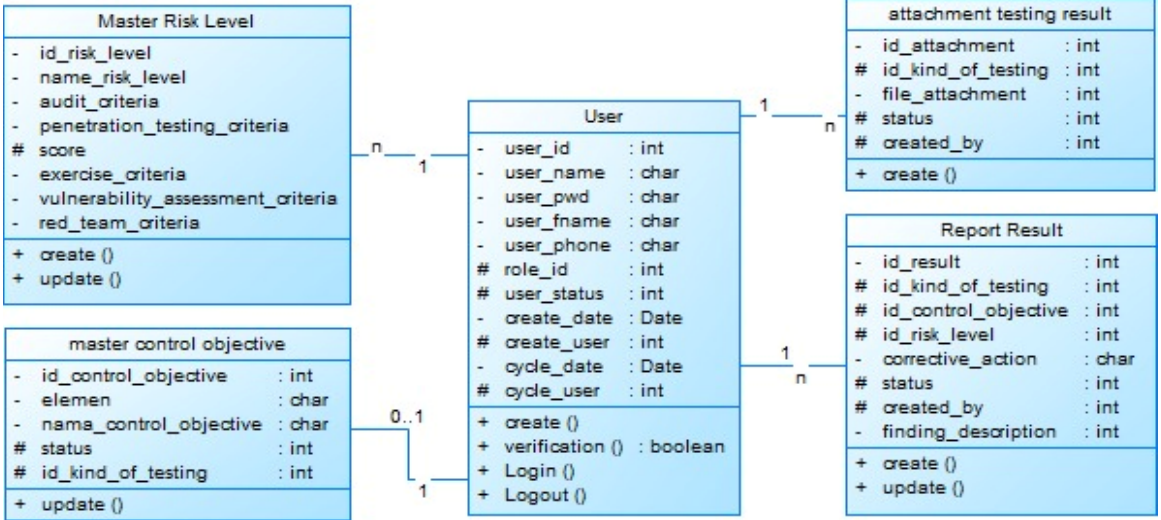
Figure 10. Class Diagram of Risk Treatment Plan Control Test Applications.